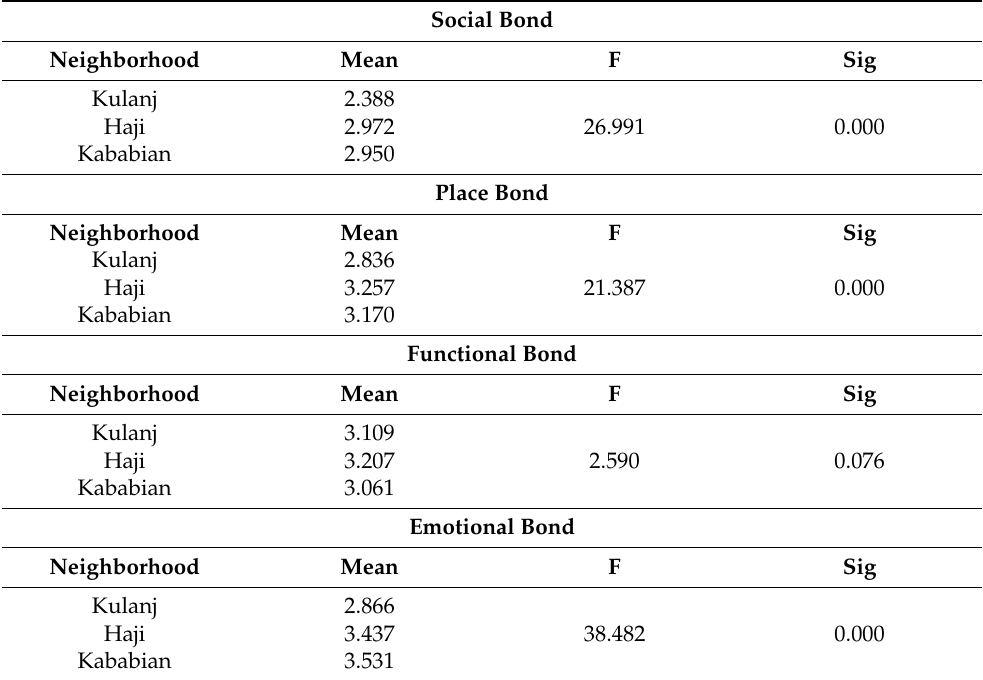
Table 4. One-way ANOVA for comparison of place, functional, emotional and social bond indices. Social